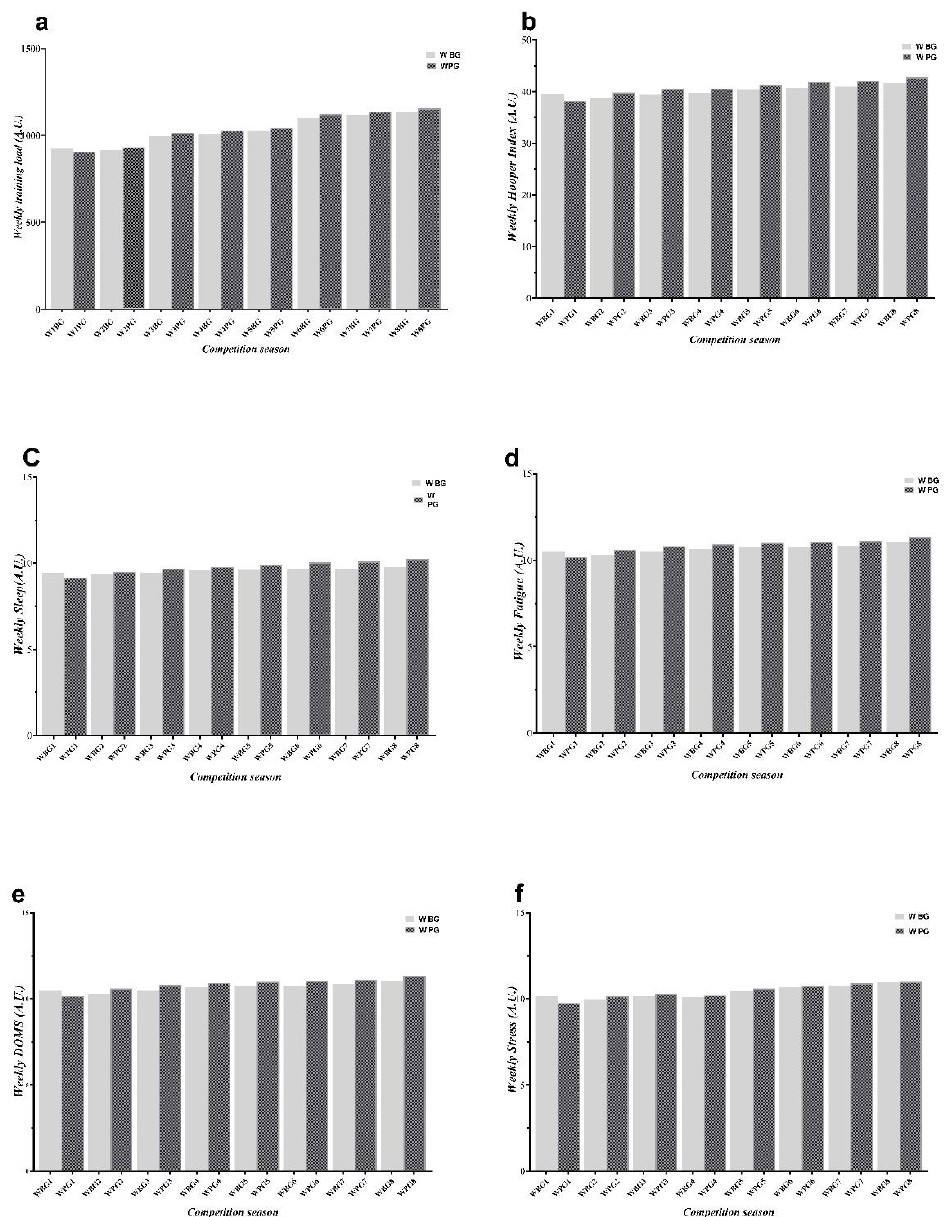
Figure 1. Change in ( a ) Training Load, ( b ) Hooper Index, ( c ) Sleep, ( d ) Fatigue, ( e ) DOMS and ( f ) Stress for 8-week in BG and PG. A.U.: Arbitrary Unit; PG: Placebo group, BG: β -alanine; DOMS: delayed onset muscle